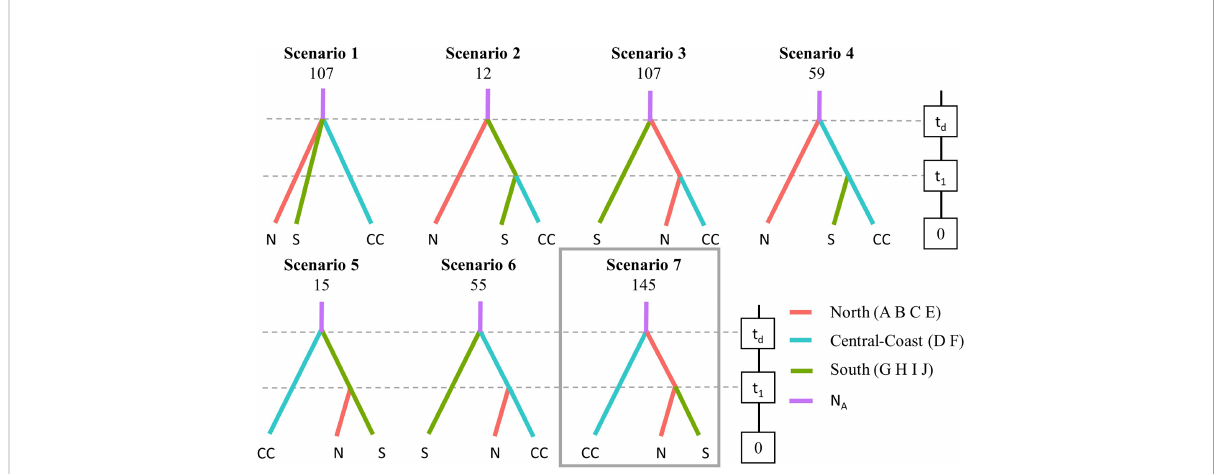
FIGURE 4 Design of DIYABC RF analysis to compare seven scenarios of population divergence. Scenario 1 represents an expansion event; scenario 2-7 represent all possibilities of divergence with a continuous population size and two divergence events. N A is the ancestral effective population size and t d and t 1 represent time events (not drawn to scale). Classifcation votes are not together with each scenario and the selected scenario (corresponding to the one with the highest vote) is indicated by a grey box (posterior probability 0.455).